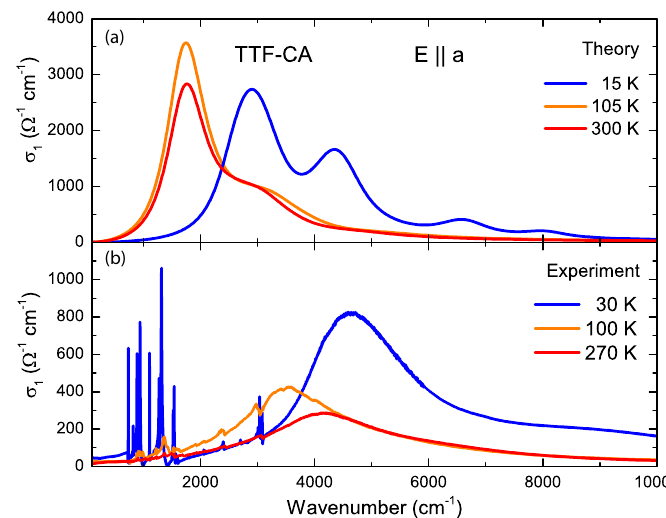
Figure 11. ( a ) Optical conductivity σ 1 ( ν ) of TTF-CA at T = 15 K (blue), 105 K (orange) and 300 K (red) along the stacking direction. The calculations were performed with the method described in Appendix B. Various electronic transitions between the lower valence bands and the unoccupied conduction band are visible; ( b ) Experimentally determined optical conductivity σ 1 ( ν ) of TTF-CA at T = 30 K, 100 K, and 270 K. In the range between 3000 cm − 1 and 10,000 cm − 1 the electronic excitations are located while the sharp features below 3000 cm − 1 can be ascribed to intramolecular vibrations.